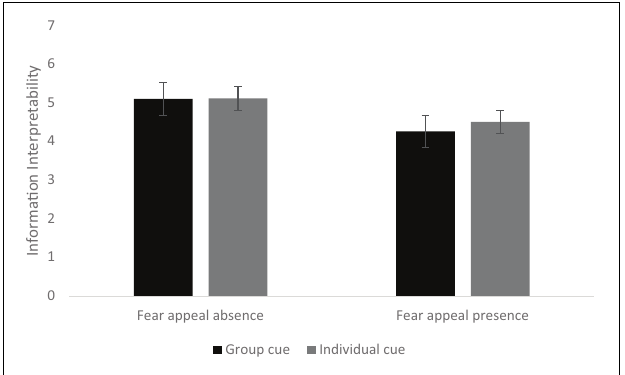
FIGURE 3 | The interaction effect of social norm appeals (individual vs. group cues) and fear appeals (absence vs. presence) on information interpretability.